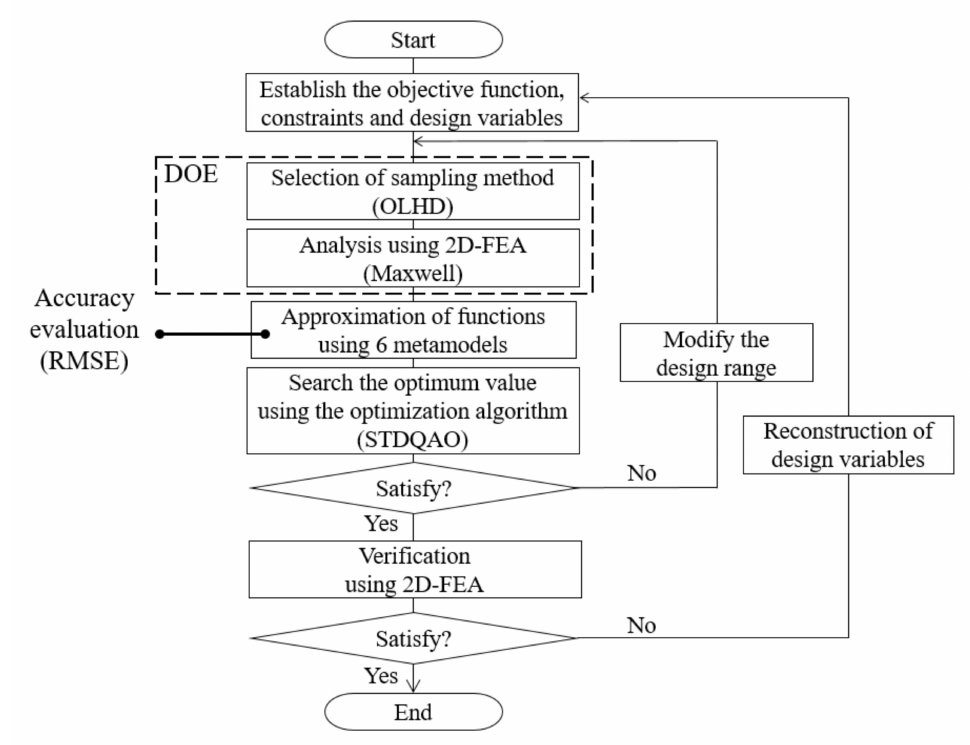
Figure 3. Flowchart of the design optimization of a PMSM.